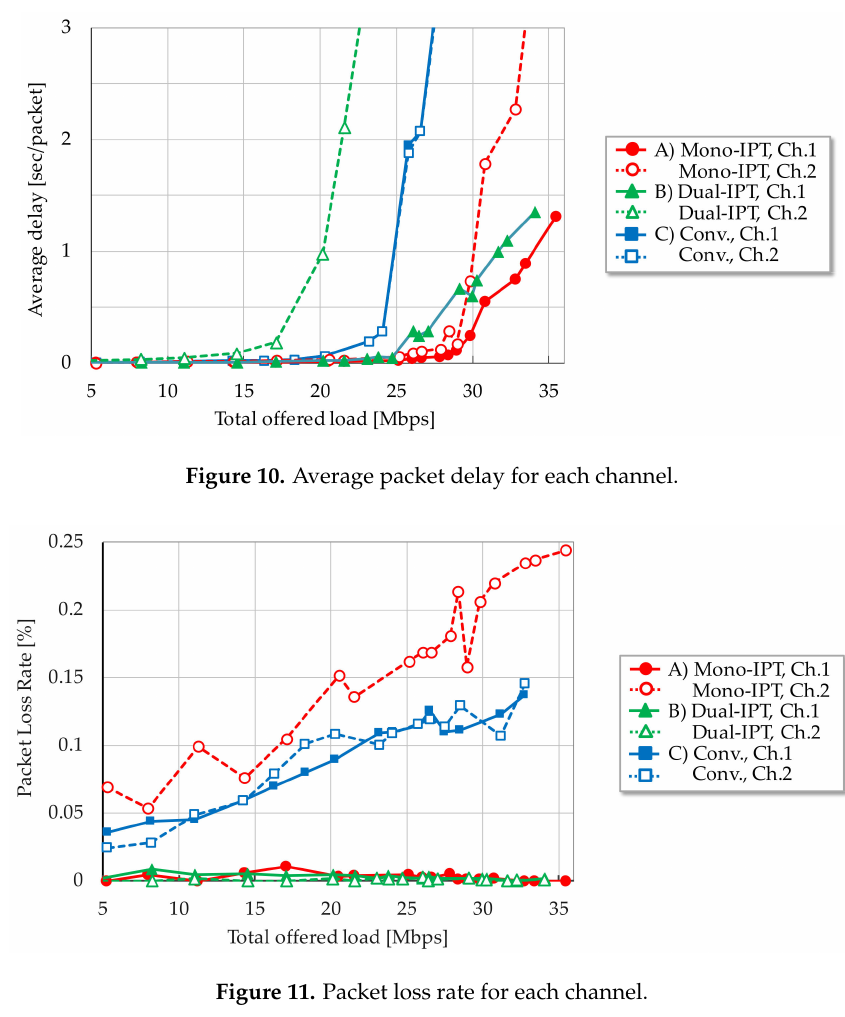
Figure 11. Packet loss rate for each